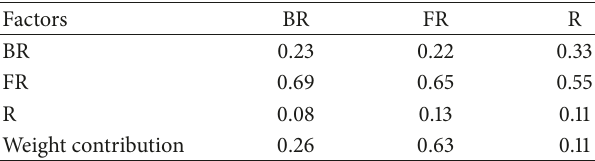
Table 23: Normalized weight matrix for application factors.